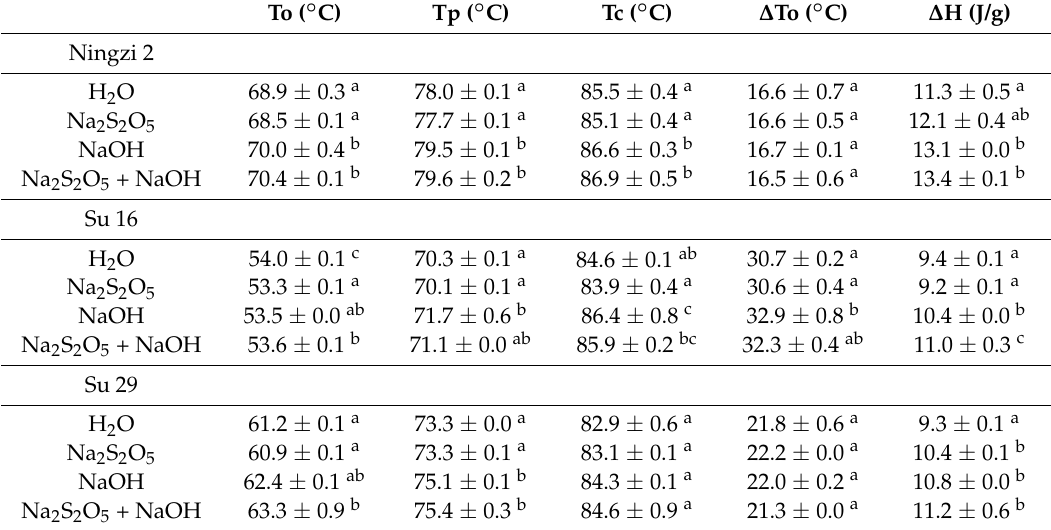
Table 4. Thermal properties of starches.